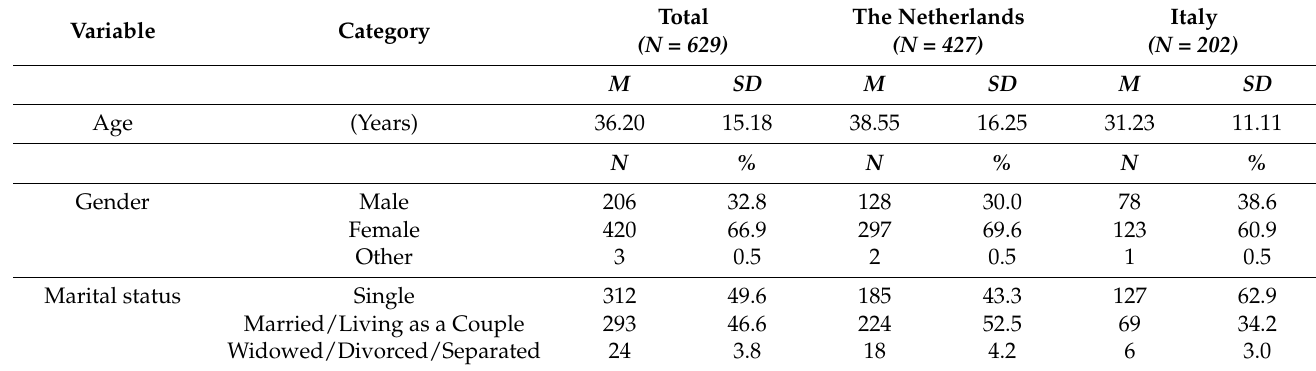
Table 1. Socio-demographic overview Italy and The